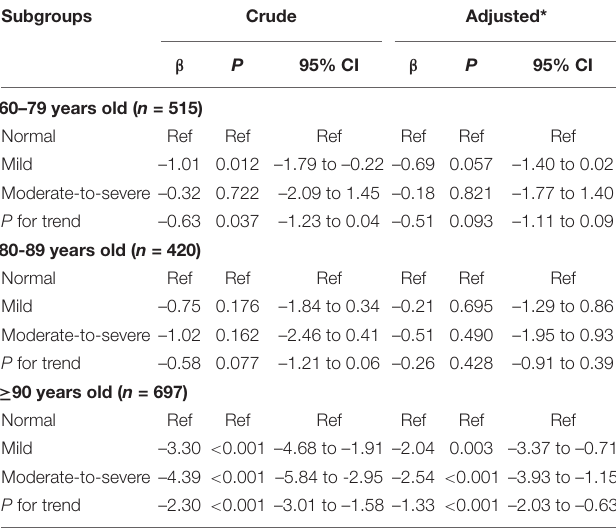
TABLE 5 | The association of malnutrition with cognitive function stratified by education